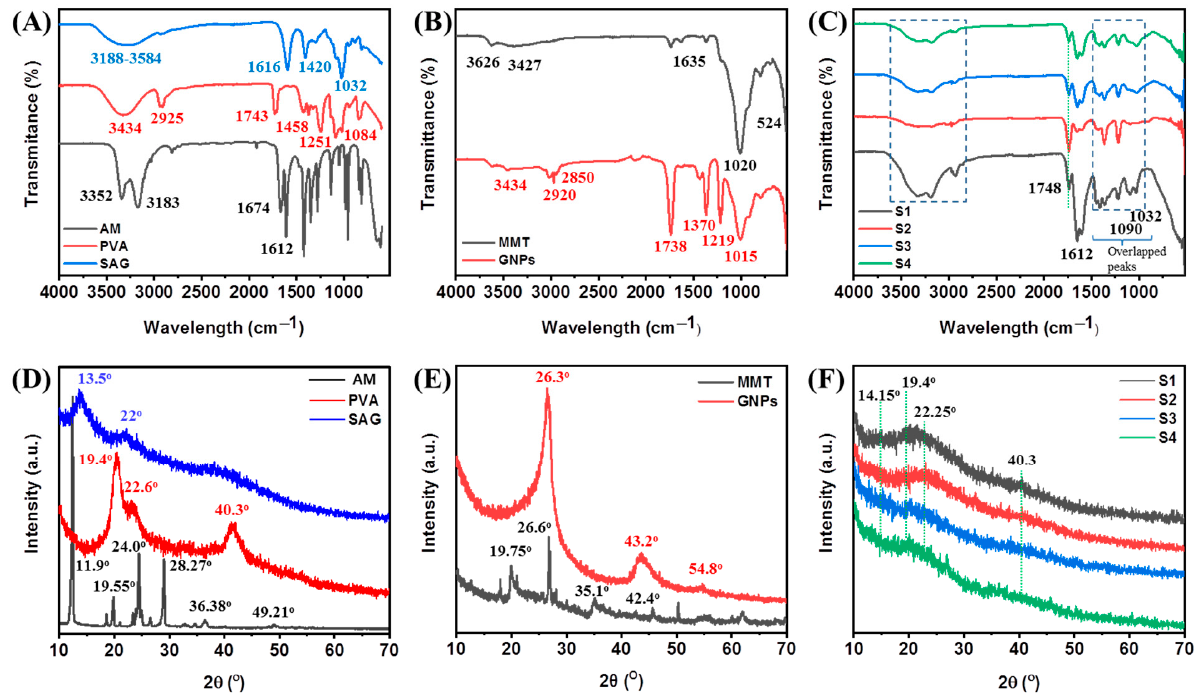
Figure 2. Structural analysis of the components and hybrid hydrogels: FTIR spectra ( A – C ) and XRD patterns ( D – F ) of the components (AM, PVA, SAG, MMT, and GNPs) and hydrogels (S1, S2, S3, and S4), respectively.